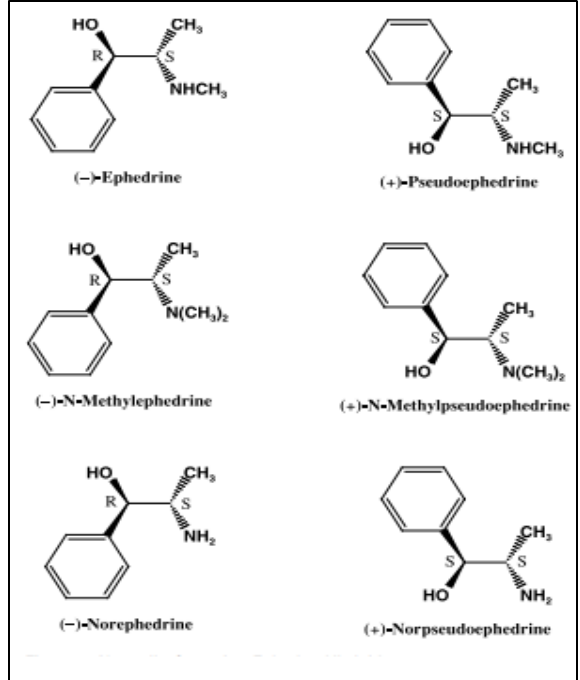
Figure 1. Ephedrine- type alkaloids Material and